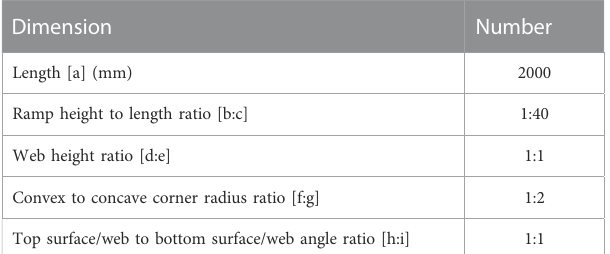
TABLE 1 Geometry